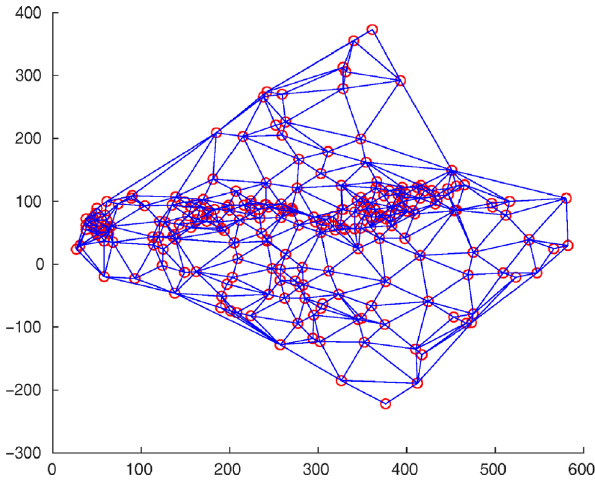
Fig. 3 Constructing a neighbor system by Delaunay triangulation. Each point x i is in X . For high-dimensional data (e.g., feature-point pairs are in 4D in homography detection), the concatenated data is projected onto the first two principal axes extracted by PCA, and the neighbor system is constructed in this 2D plane. Distant edges are removed.